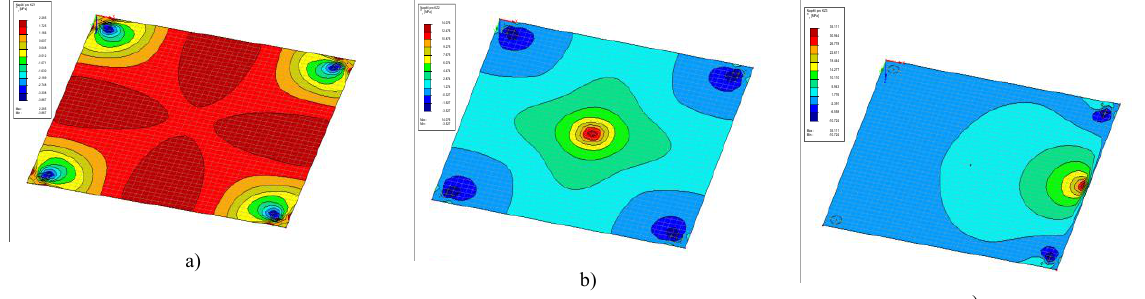
Fig. 4 Stress distribution patterns from the numerical analysis of the representative glass pane a) uniformly distributed areal load, b) concentrated load in the middle of the pane c) concentrated load near the edge of the pane.